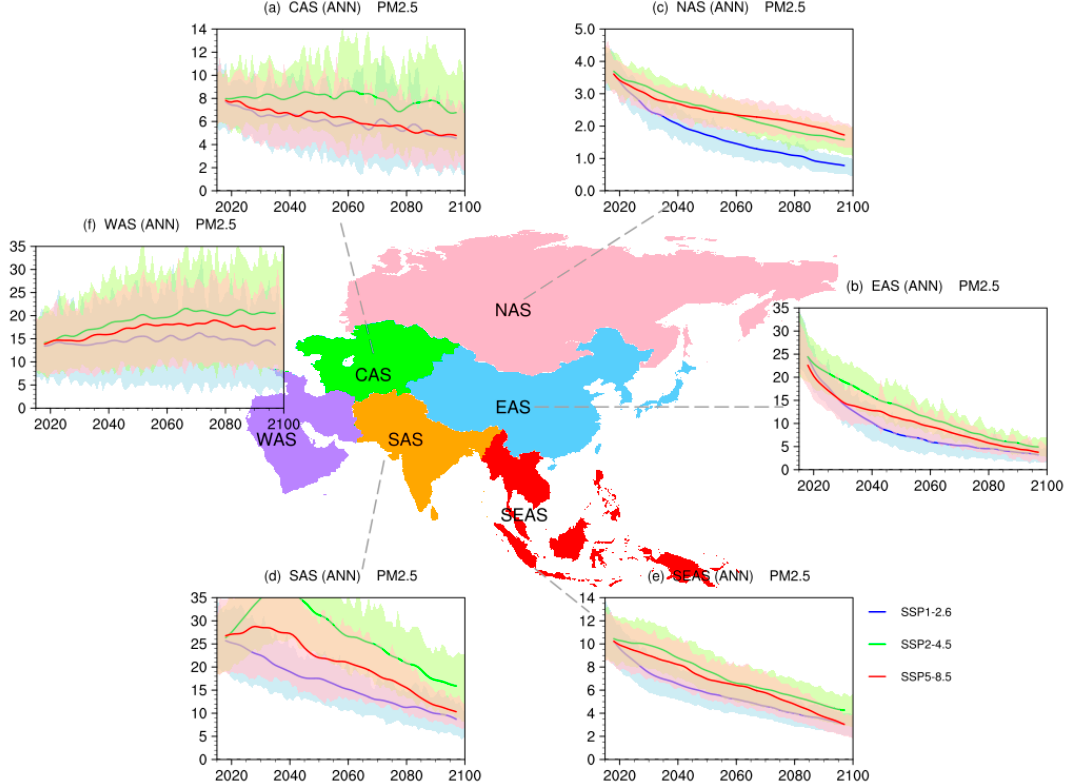
Figure 7. Time evolutions of population-weighted annual mean surface PM 2.5 concentrations (units: µg/m 3 ) over Asia under SSP1-2.6 (blue), SSP2-4.5 (green), and SSP5-8.5 (red), where shadings indicate model uncertainty range (1 standard deviation of the simulations).